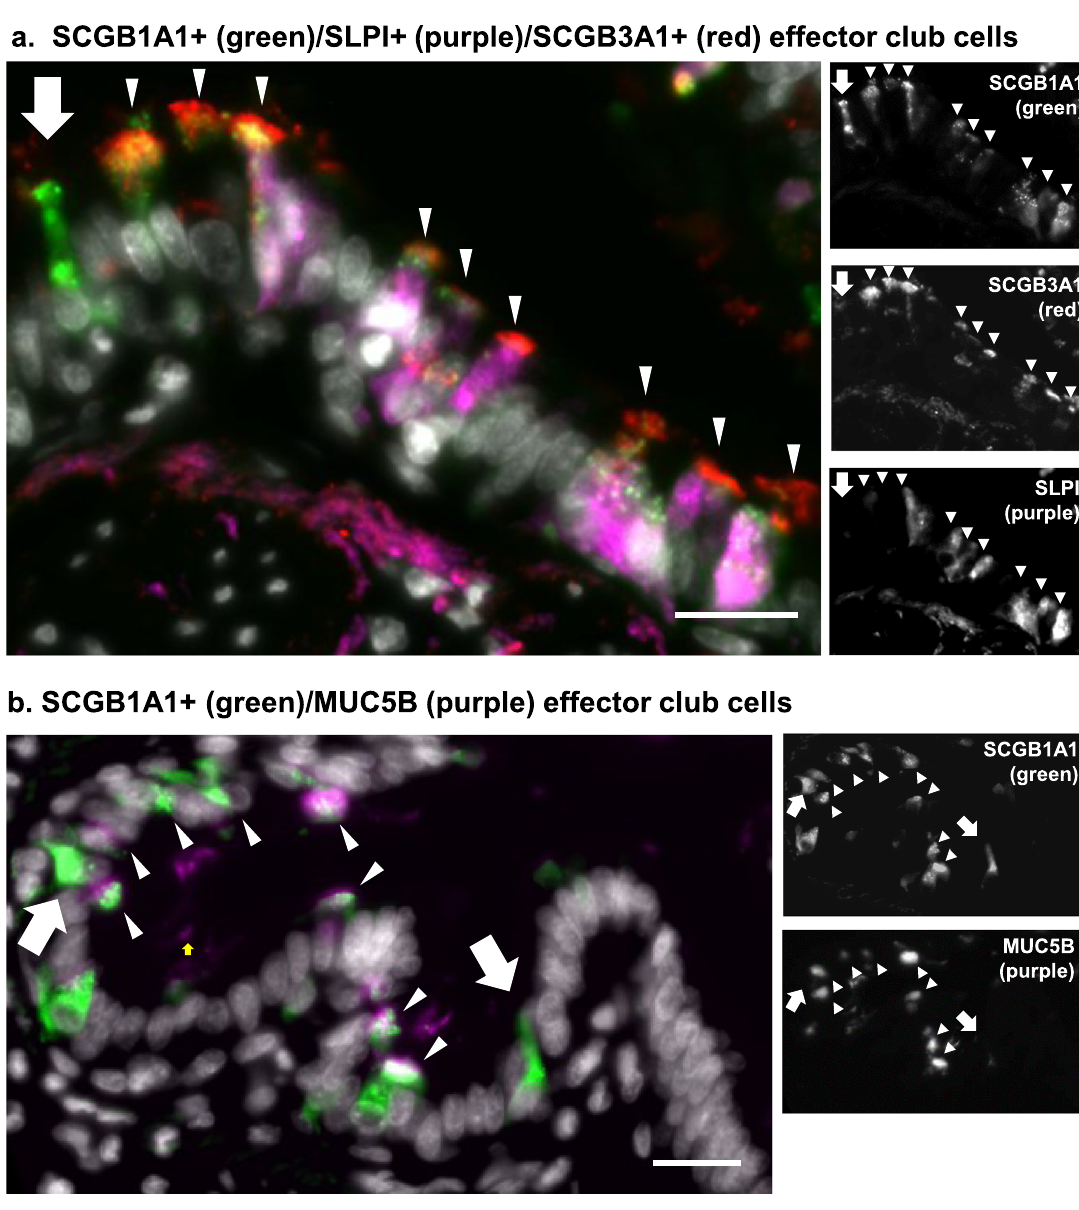
Fig. 2 Immunohistochemistry assessment of club cell heterogeneity in the human lung. Airway in adult normal nonsmoker human lung was analyzed for club cell subtypes. Club cells were identi fi ed as SCGB1A1 + cells (green) and subsets were identi fi ed using various markers in the single cell sequencing. a Secretoglobin family 3A member 1 (SCGB3A1) (red) and secretory leukocyte protease inhibitor (SLPI) (purple). b SCGB1A1 (green), mucin 5B (MUC5B; purple). Club cells that only express SCGB1A1 but no secondary markers are denoted with a white arrow. Club cells expressing multiple markers are denoted with a white arrowhead. Scale bar = 20 μ